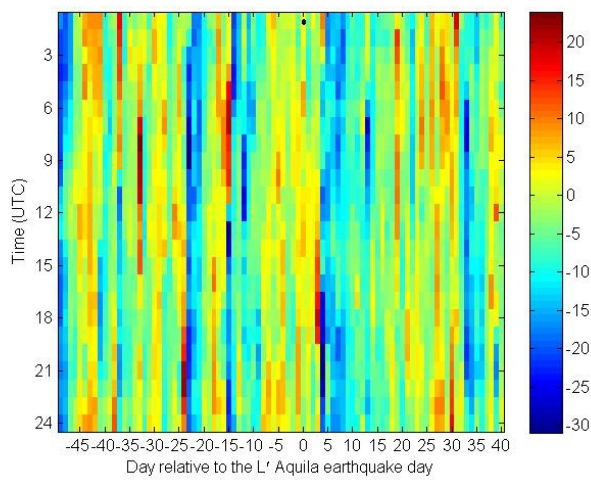
Fig.2. Changes of D st index in time interval corresponding to L’Aquila earthquake Fig. 3. Changes of M index in time interval corresponding to L’Aquila